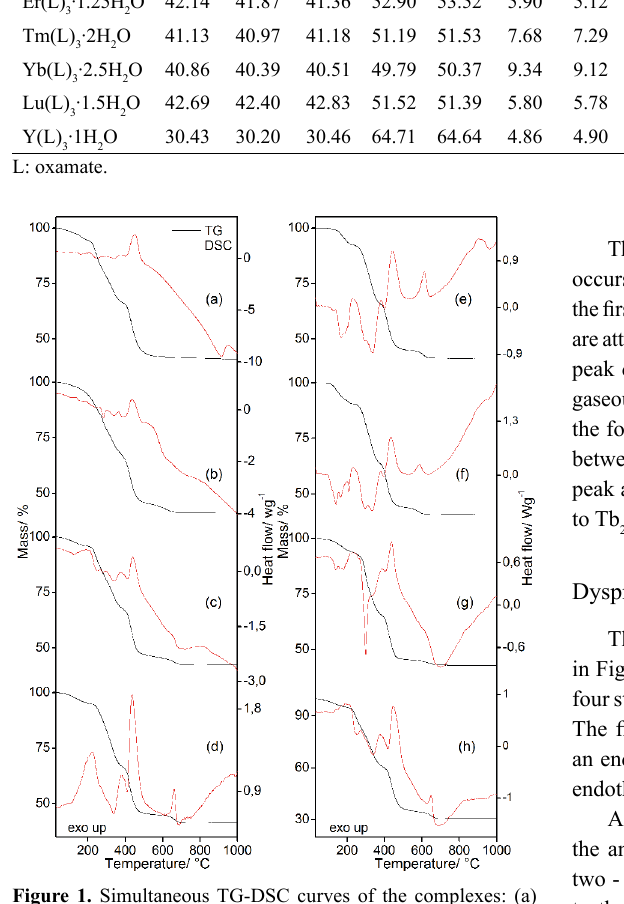
∙1H O, (c) Ho(L) ∙1H O, (d) Er(L) ∙1.25H 3 2 3 2 3 ∙2.5H O, (g) Lu(L) ∙1.5H O and (h) 3 2 3 2